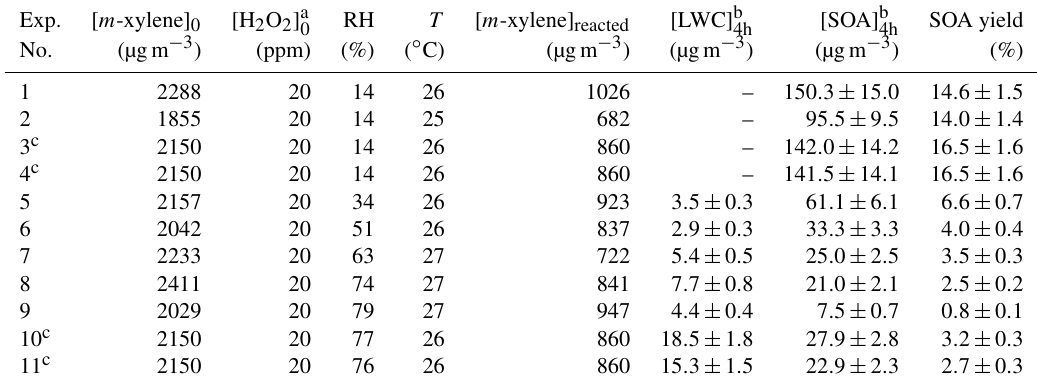
Table 1. Experimental conditions and results at 4h of experiments in m -xylene–H 2 O 2 photooxidation system. Exp. [ m -xylene] 0 [H 2 O 2 ] a